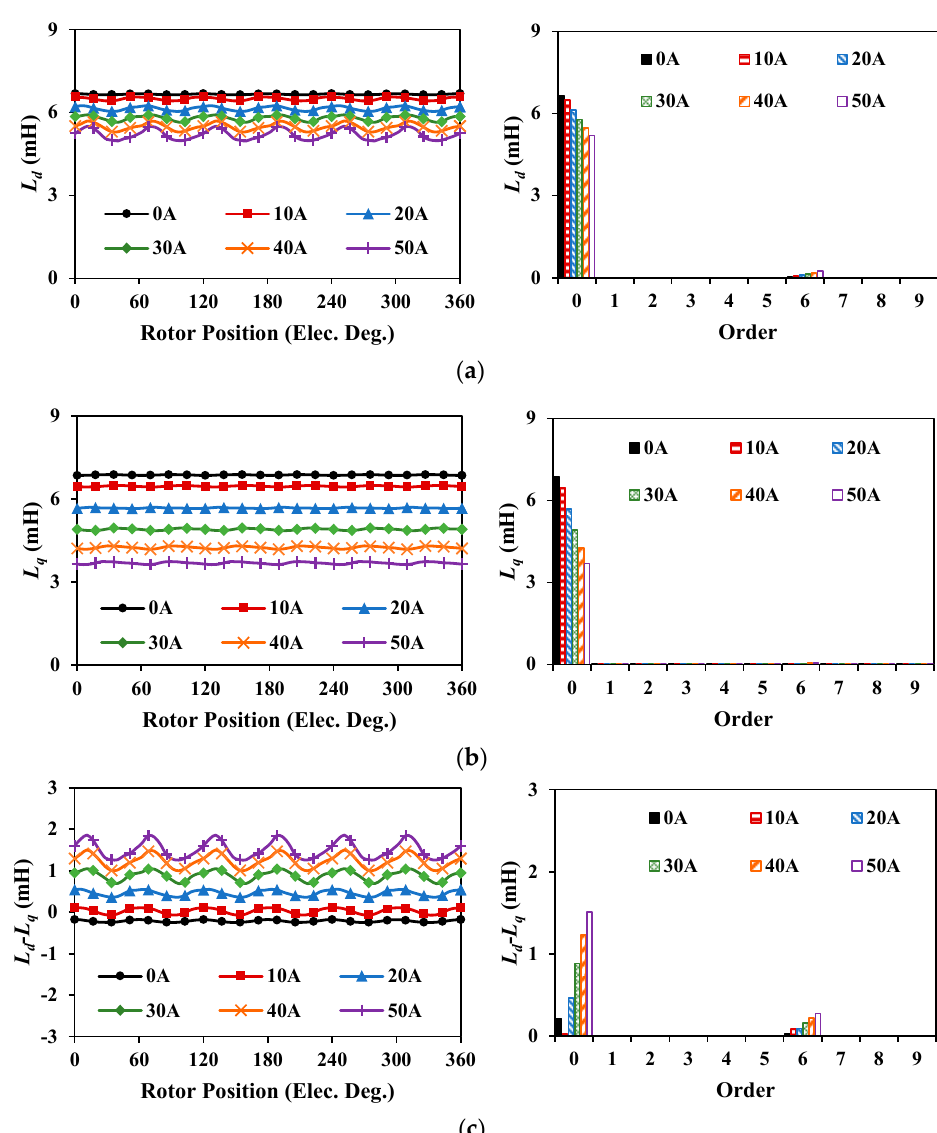
Figure 31. Inductances and spectra of 12s8p-PSCPPM machine. ( a ) L d . ( b ) L q . ( c ) L d - L q .